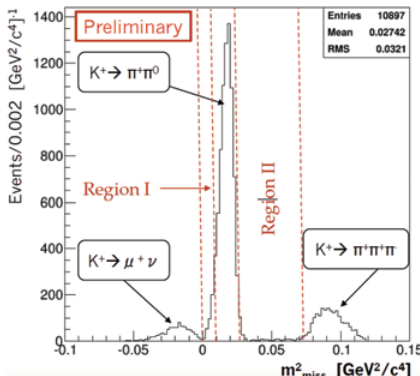
Figure 5. the m 2 miss distribution after the signal event selection. Two regions for the final selection of signal events are indicated by the vertical red-dashed lines. The kaon decays contributing to the distribution are